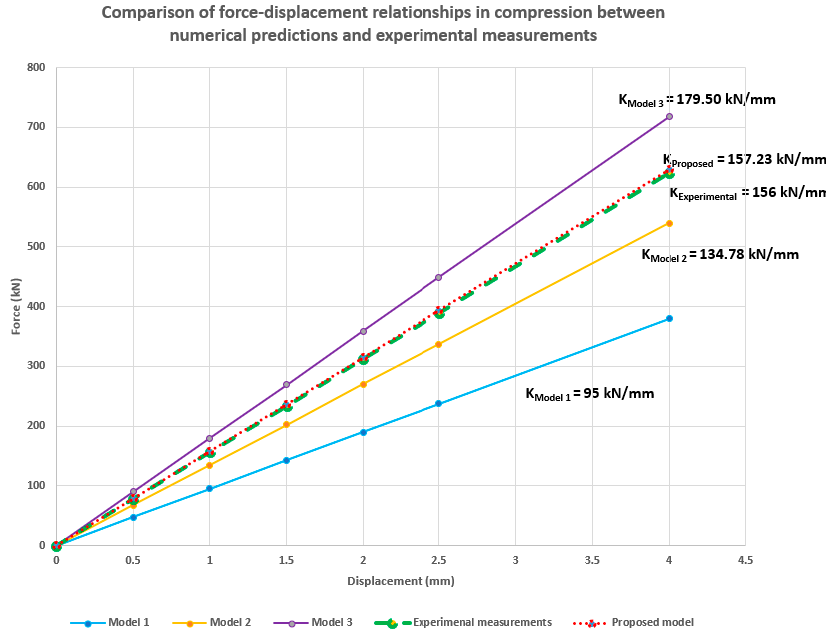
Figure 13. A comparison of the vertical stiffness of the meta-functional auxetic composite bridge bear-